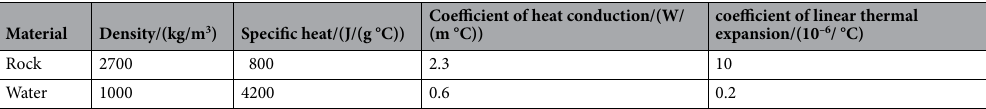
Table 1. Thermo-physical parameters of solid and